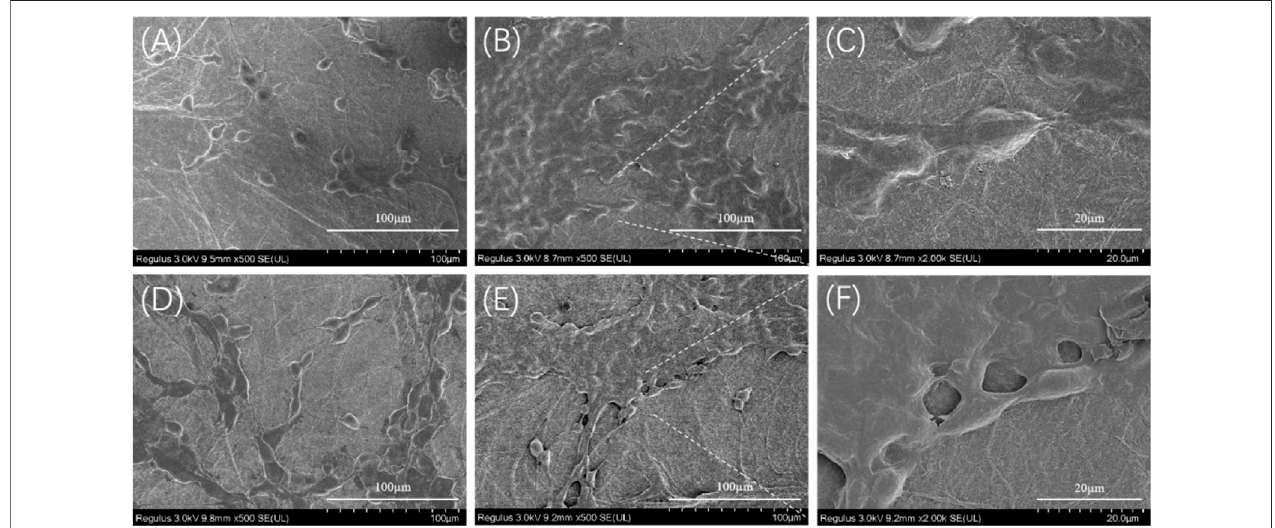
FIGURE11| SEMimagesofNIH-3T3cellsgrowingon30TSFand30BSFfor3 daysand7 days (A) NIH-3T3cellsgrownon30TSFfor3 days (B – C) NIH-3T3cells grown on 30TSF for 7 days (D) NIH-3T3 cells grown on 30BSF for 3 days (E – F) NIH-3T3 cells grown on 30BSF for 7